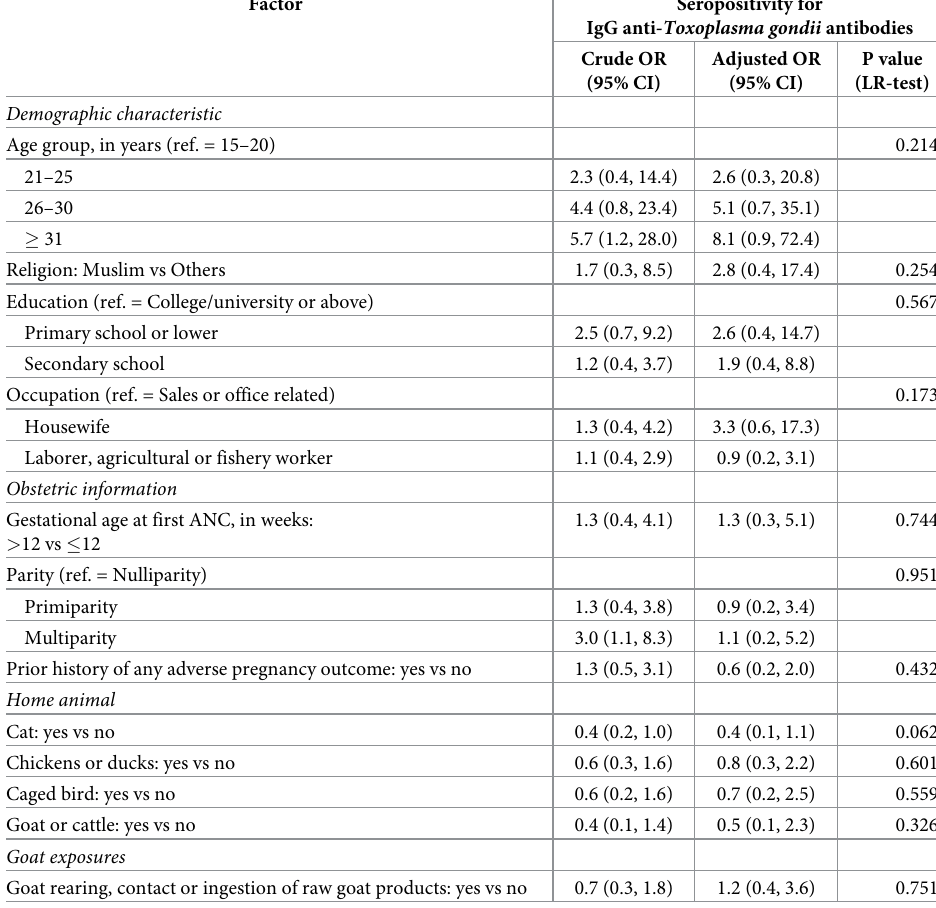
IgG anti- Toxoplasma gondii antibodies Crude OR Adjusted OR P value (95% CI) (95% CI) (LR-test)